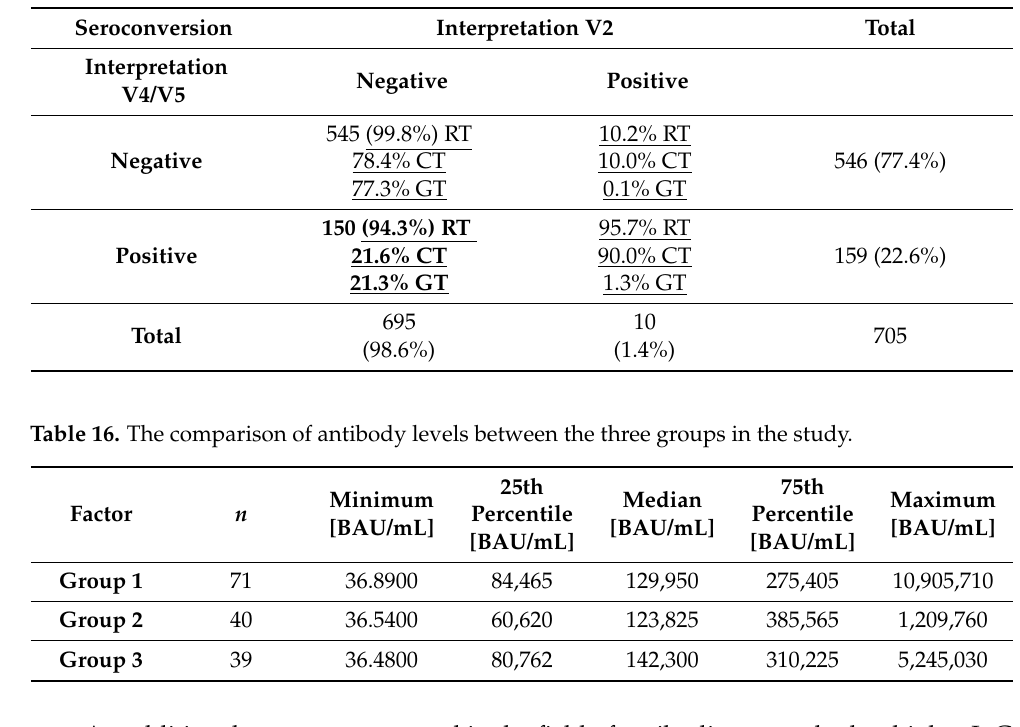
Table 15. The seroconversion between visits V2 and V4/5.